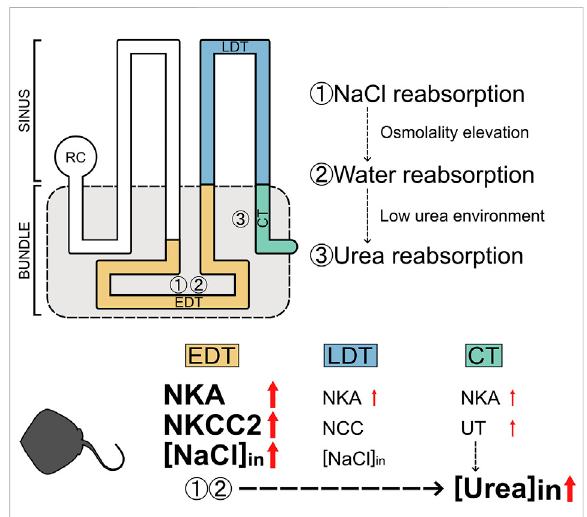
Schematic summary for the enhancement of NaCl and urea reabsorptioninthekidneysofredstingrayfollowingacclimationto low-salinity environment. [NaCl] in and [Urea] in indicate reabsorptions of NaCl and urea,